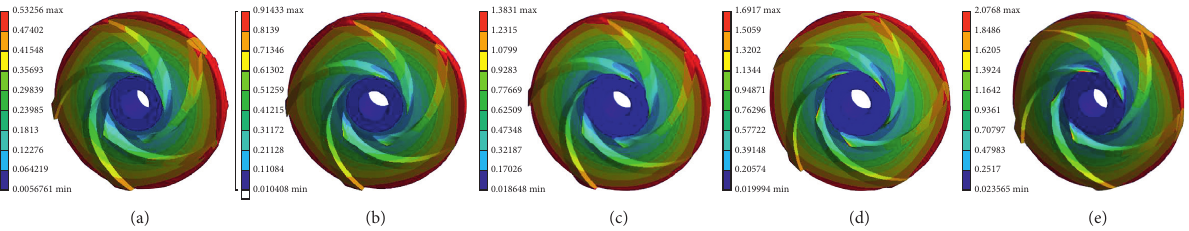
Figure 10: Deformation diagram of the impeller surface. (a) 1 atm. (b) 3 atm. (c) 5 atm. (d) 8 atm. (e) 10